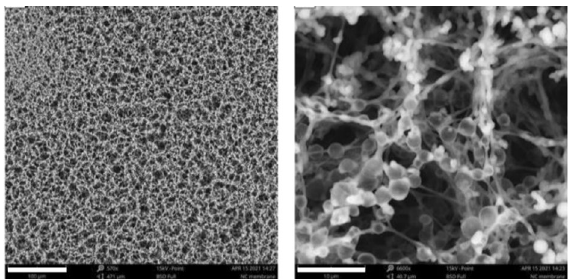
Figure 1. SEM images of NC membrane. SEM analysis of the structure of NC membrane with a magnification of 570× (left) and 6600× (right). Scale bars: 100 µm (left) and 10 µm